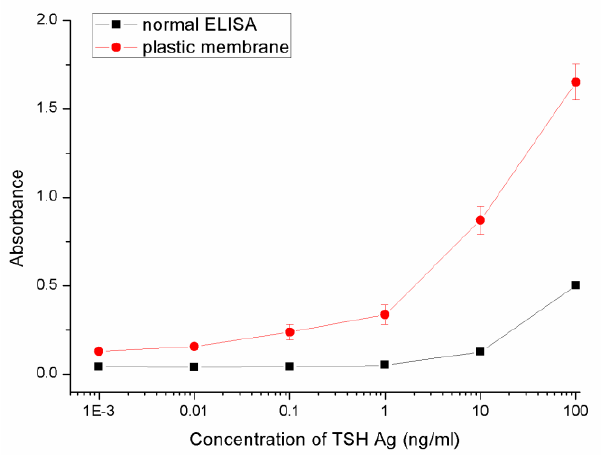
Figure 3. ( a ) Comparison between the conventional ELISA (black line) and meshed PS membrane type ELISA (red line) against a concentration of IgG antigens and ( b ) the effect of different materials on optical density.